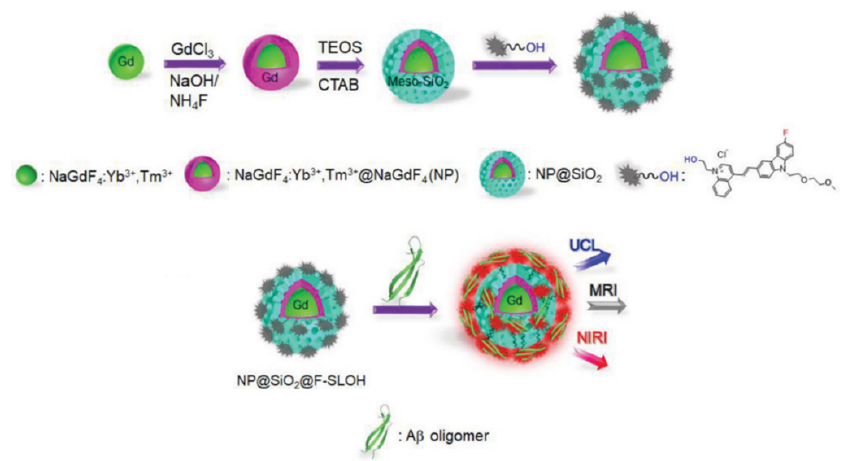
Figure 14. Schematic illustration of mesoporous silica-coated upconversion nanoparticles composed of a gadolinium doped UCNP core (noted as NP), mesoporous silica shell (labelled SiO 2 ) and Aβ oligomer-selective cyanine dye coating (noted as F-SLOH). The gadolinium-doped UCNP core provides T 1 MRI contrast and the selective binding of Aβ oligomers to the F-SLOH dye facilitates target activated NIR fluorescence (denoted near infrared imaging, NIRI). UCL refers to upconversion luminescence. Reprinted with permission from reference [171]. Copyright (2020) Wiley-VCH.